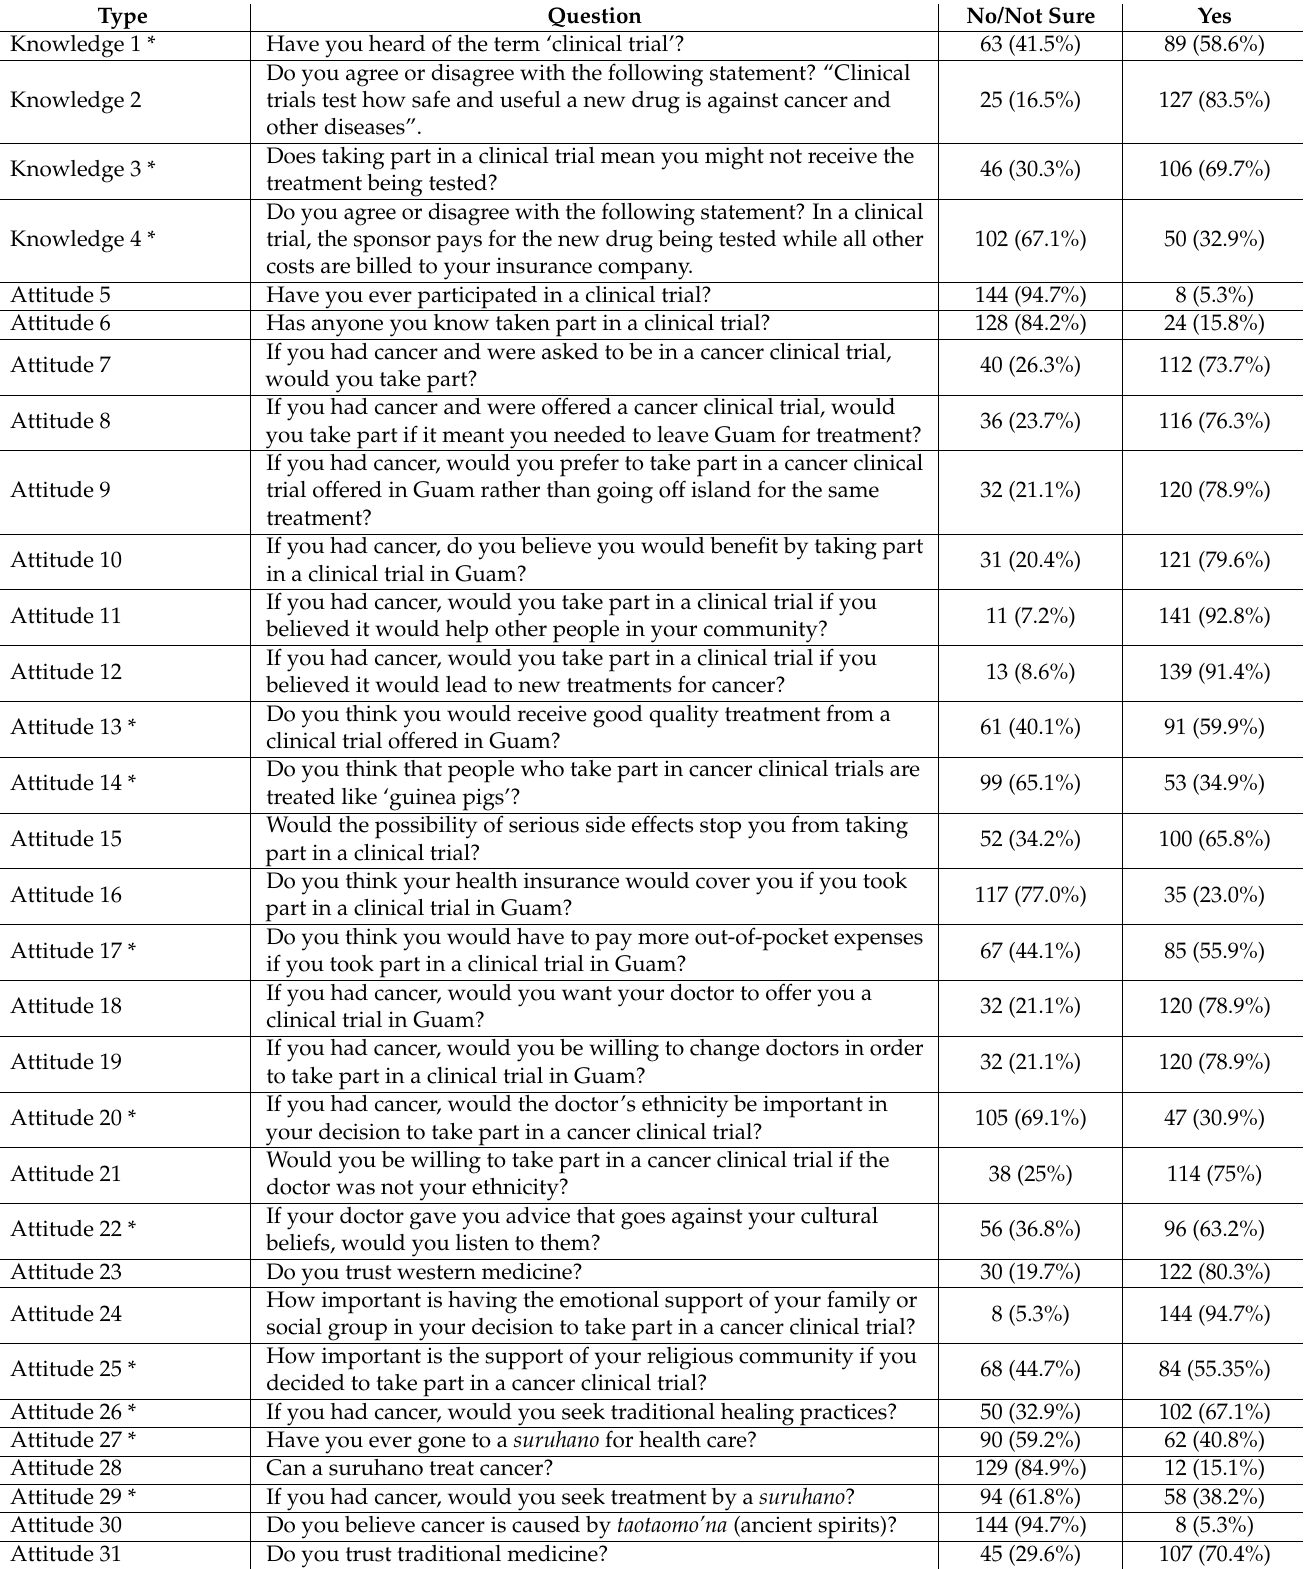
Table 2. Knowledge and Attitude Survey Question Response